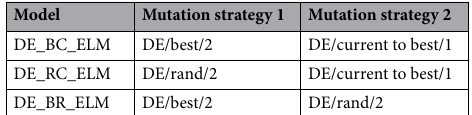
Table 10. Settings of the dual-strategy models.